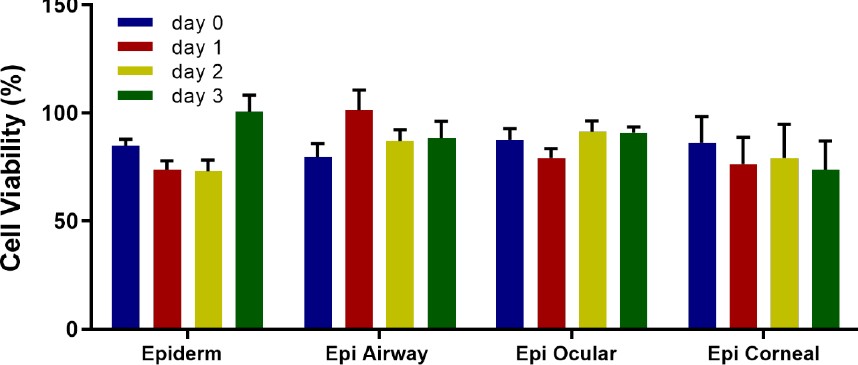
Figure 9. Viability of several constructs after vitrification in vials and a deep-well plate. The indicated constructs were vitrified with VS55/VS70. After rewarming, viability was measured using the resazurin assay and is the mean(±SEM) of ≥8 replicates.